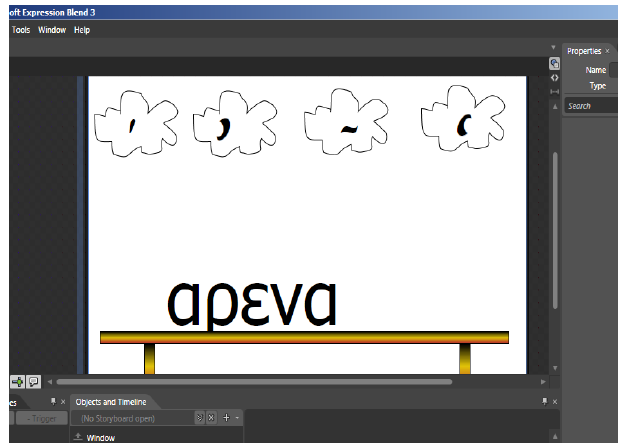
Figure V. Animating and developing words